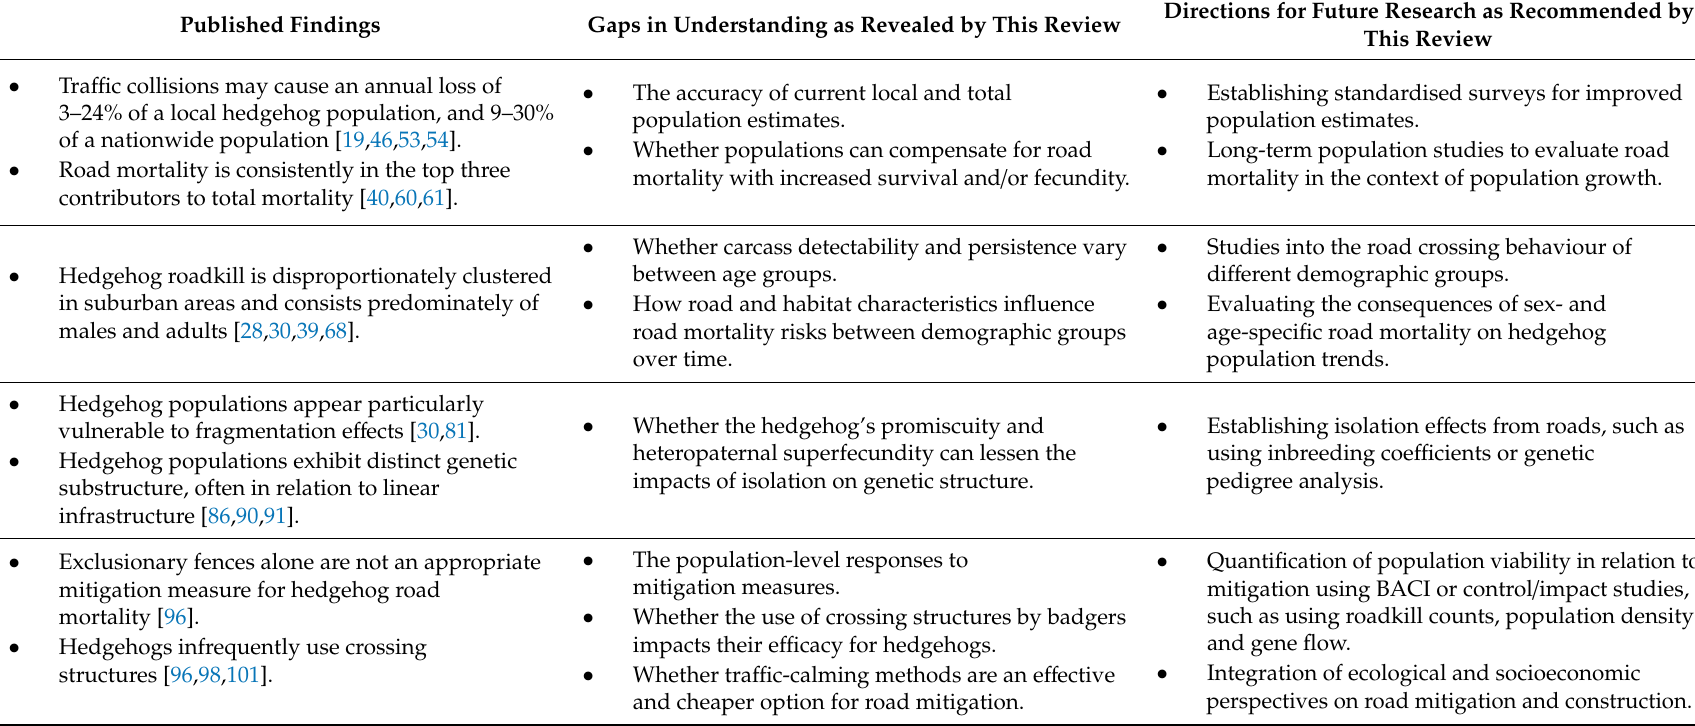
Table 3. Summary of published findings, as well as gaps in the literature and recommendations for future research as discussed in this review. Published